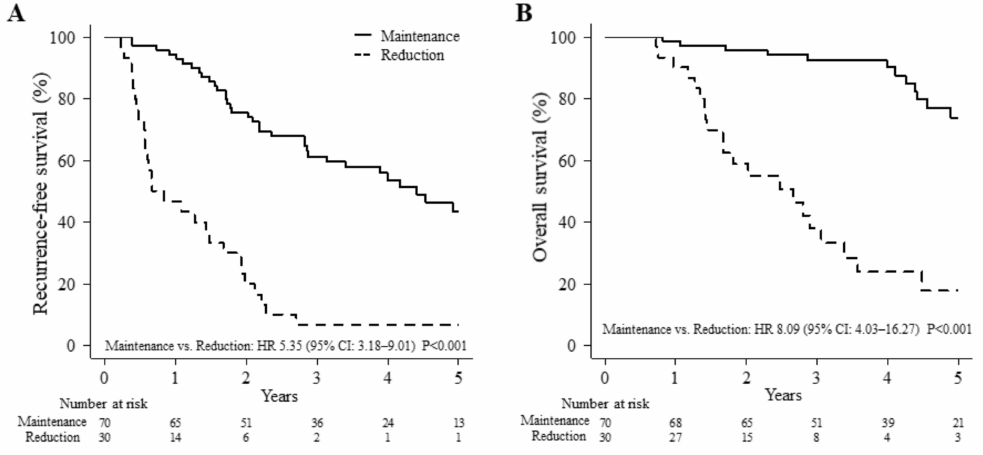
Figure 2. A comparison of long-term outcomes in the G8 score between the two groups.